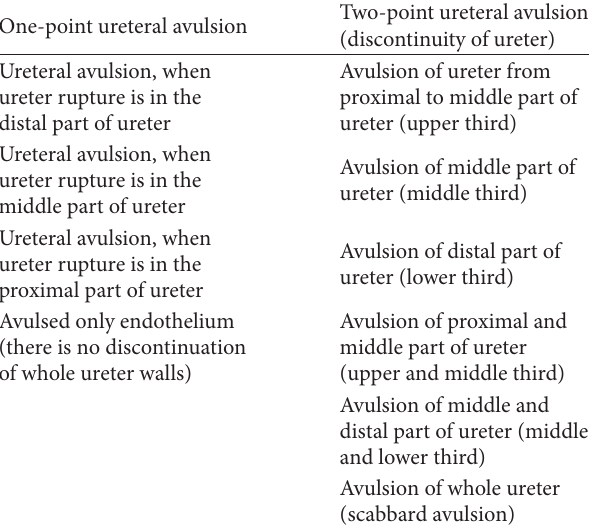
Table 1: Classification of ureteral